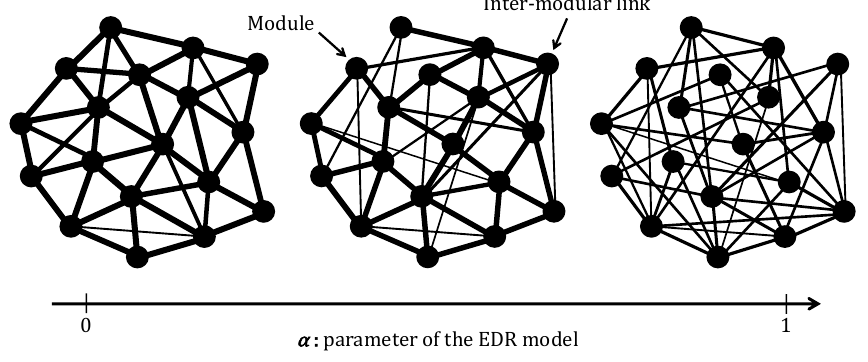
Figure 3. Relationship between parameter α and the topological